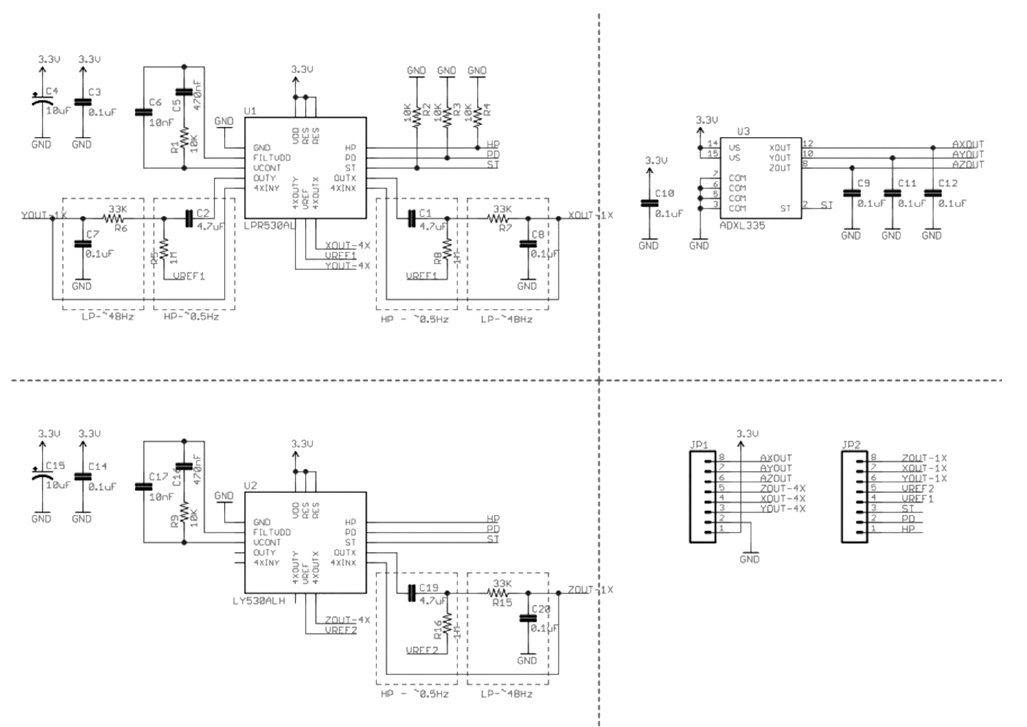
Figure B1. Schematic of the sensors including the accelerometer and two